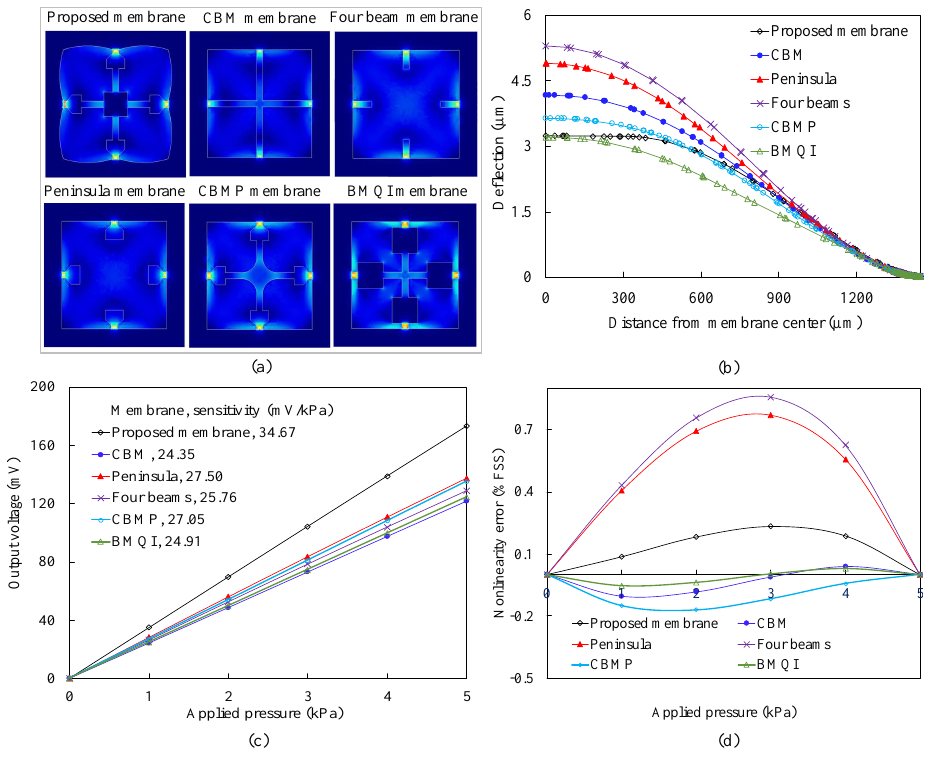
Figure 9. ( a – d ) Comparison to other structural